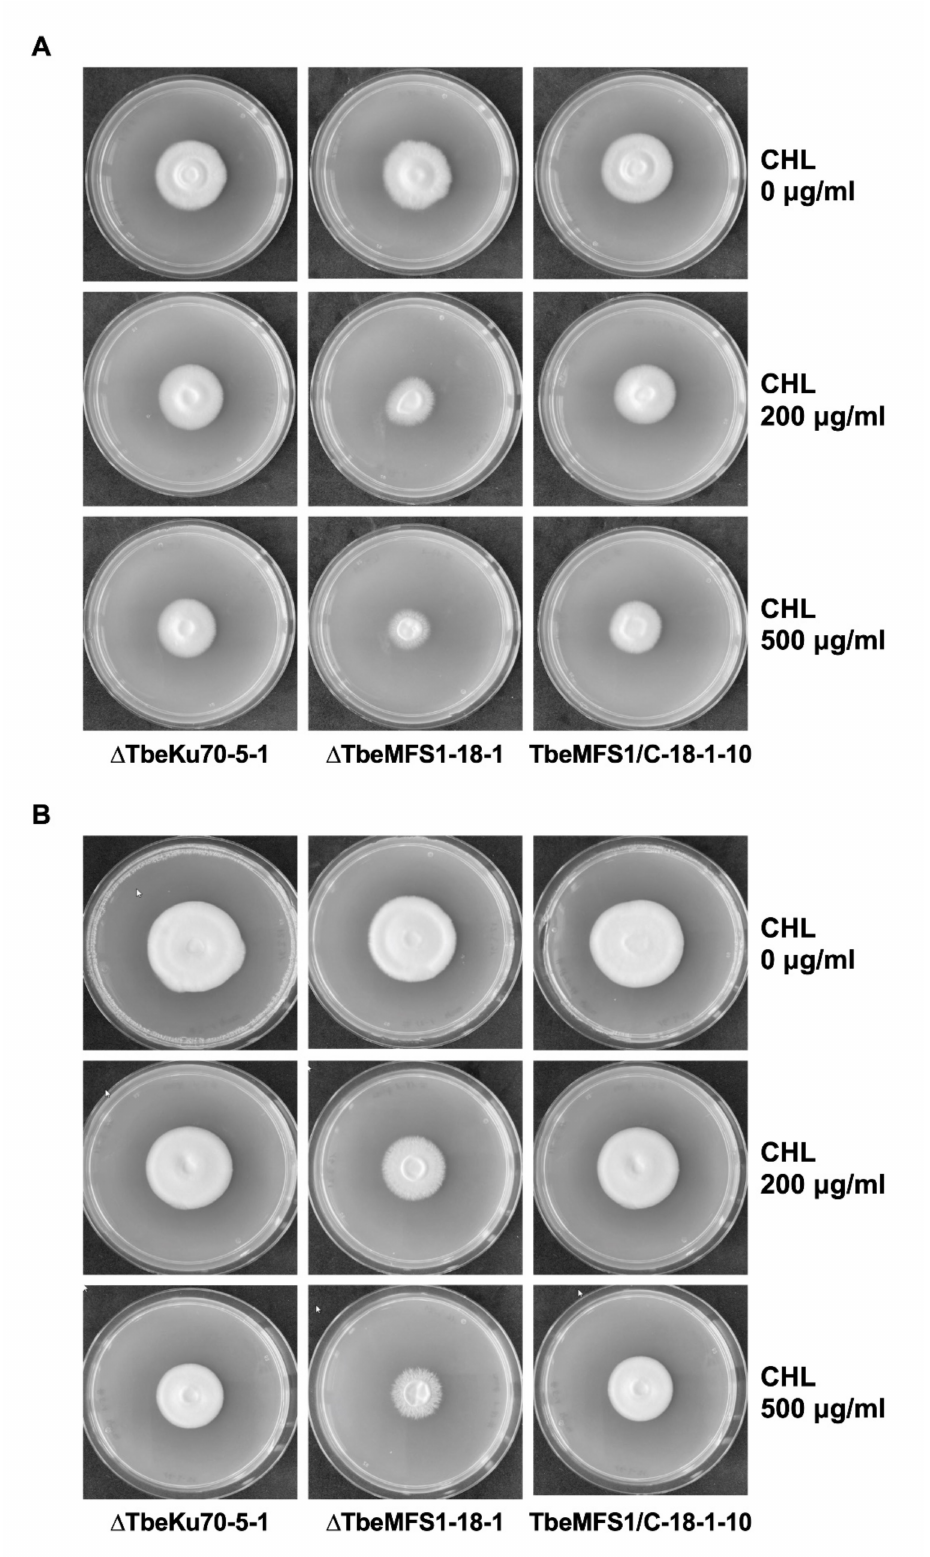
Figure 4. Targeted disruption of the MFS1 gene makes T. benhamiae susceptible to CHL. The effect of CHL (200 and 500 µ g/mL) in SDA medium ( A ) and SGA medium ( B ) on the growth of T. benhamiae ∆ TbeKu70-5-1 (Parent strain), ∆ TbeMFS1-18-1 ( TbeMFS1 -lacking mutant), and TbeMFS1/C-18-1-10 (Revertant